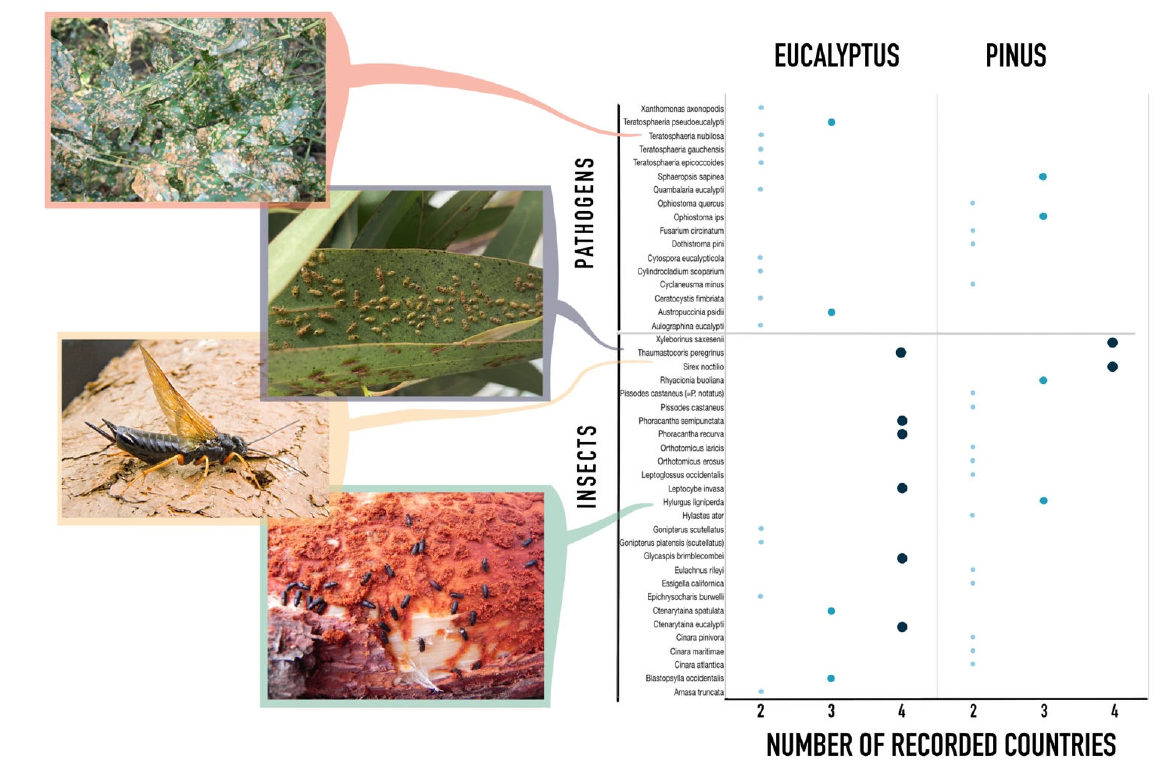
Figure 2. Shared forest pests recorded in the Southern Cone of South America (Argentina, Brazil, Chile, and Uruguay). Only species recorded from two or more countries are listed as circles. Images of Teratosphaeria nubilosa , Thaumastocoris peregrinus , Sirex noctilio , and Hylurgus ligniperda are shown (top to bottom).